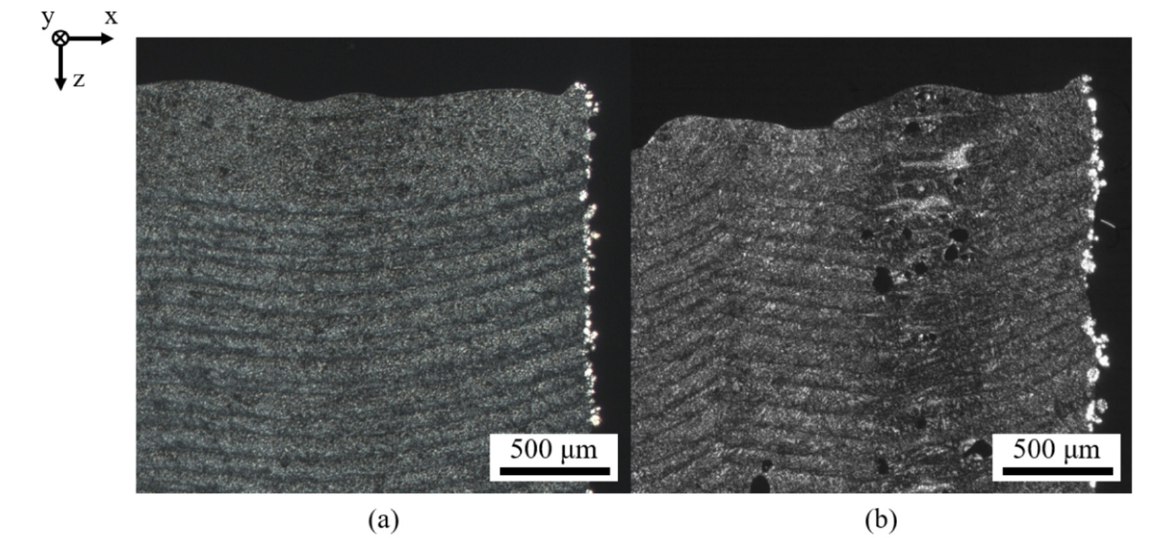
Figure 10. Polarization micrographs of cubic samples manufactured applying a powder bed temperature of 75 °C ( a ) and 100 °C ( b ).